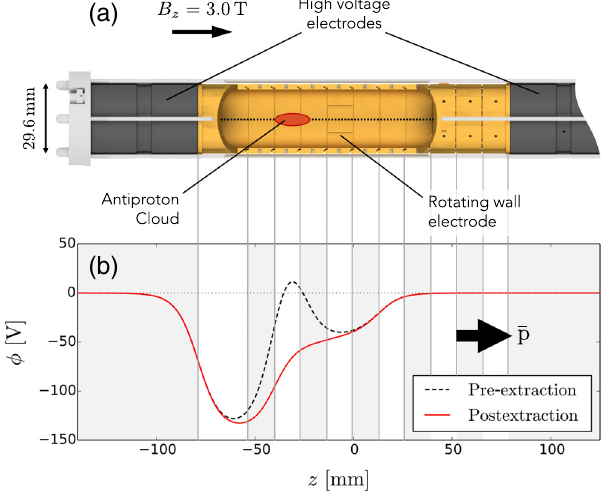
FIG. 2. Diagram showing (a) a cross section of the catching trap electrode stack and (b) the on-axis electric potential ϕ used to eject a ∼ 50 -eV antiproton bunch. The dashed line shows the asymmetric ∼ 52 V potential well used to hold the ¯ p cloud prior to extraction, and the solid line shows the potential immediately after the extraction of the ¯ p